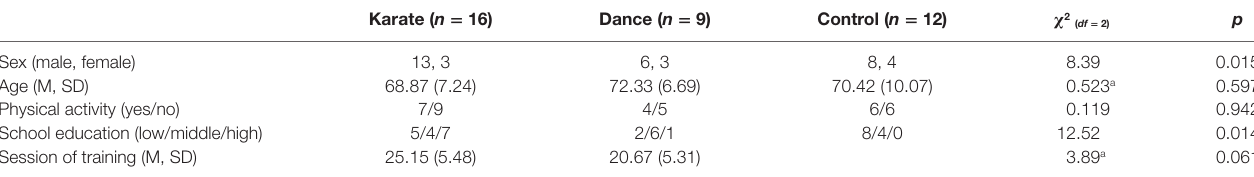
TaBle 1 | Demographic data dependent on the training